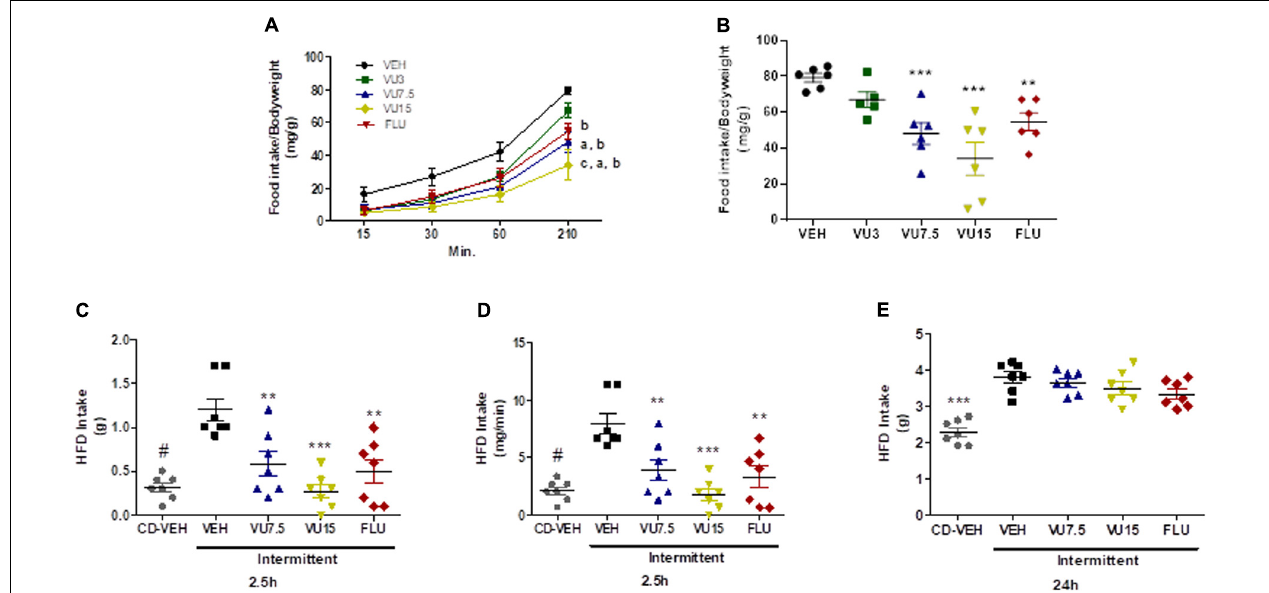
FIGURE 5 | NAM VU0409106 reduced binge-like eating behavior in C57BL/6 mice. Fasting-induced food intake results are shown in A and B. (A) Food intake after 15, 30, 60, and 210 min of food return to the cage (a: different from vehicle at time 60; b: different from vehicle at time 210; and c: different from vehicle at time 30 after Bonferroni multiple-comparison post hoc test). (B) Food intake at 210 min ( n = 6), ** p < 0.01 and *** p < 0.001 compared to vehicle after Bonferroni multiple-comparison post hoc test. Intermittent-HFD-induced binge-like eating results are shown in (C–E) . HFD intakes were monitored (C,D) 2.5 h and (E) 24 h after presentation of HFD ( n = 7), # p < 0.05, ** p < 0.01, and *** p < 0.001 after Bonferroni multiple-comparison post hoc